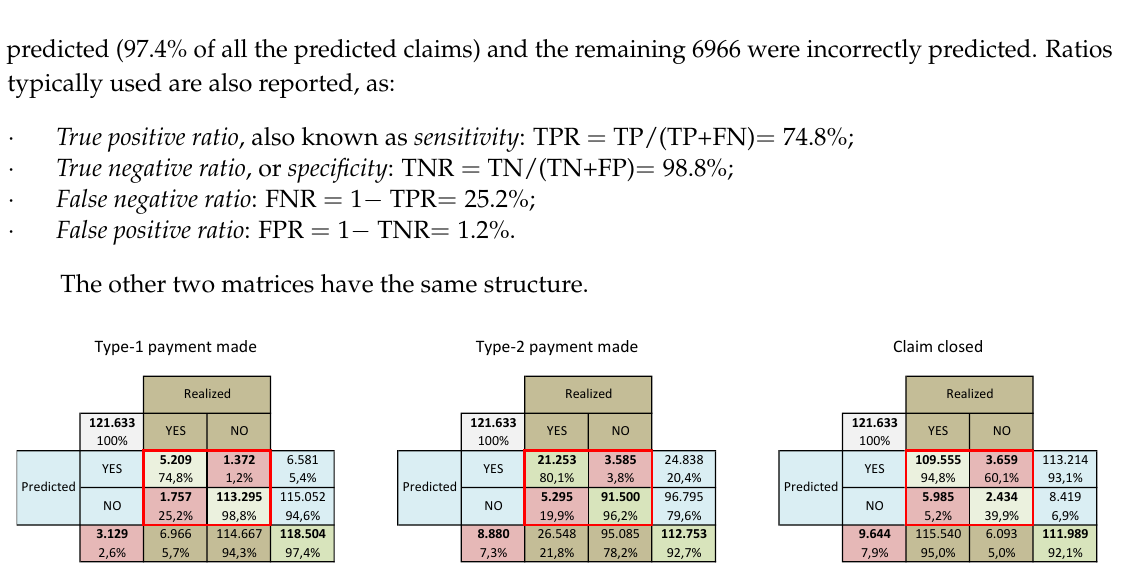
Figure 6. Confusion matrices for prediction of payment and closure indicators for claims with (cid:96) =